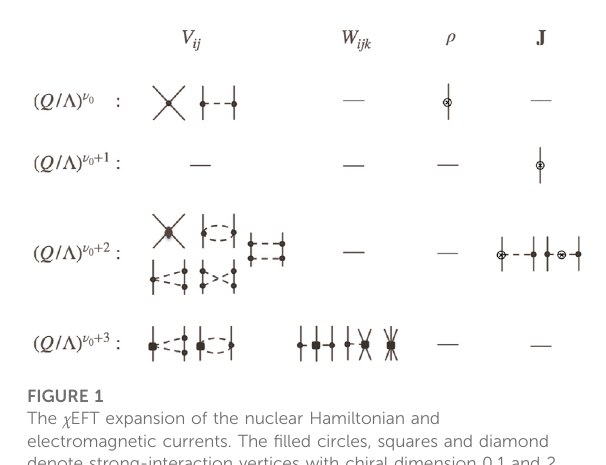
FIGURE 2 Feynman diagrams for the photoabsorption process (left), where a realphoton γ isexchanged,andtheelectron scatteringprocess, where a virtual photon γ *isexchanged between theprobeand thenucleus (cyan